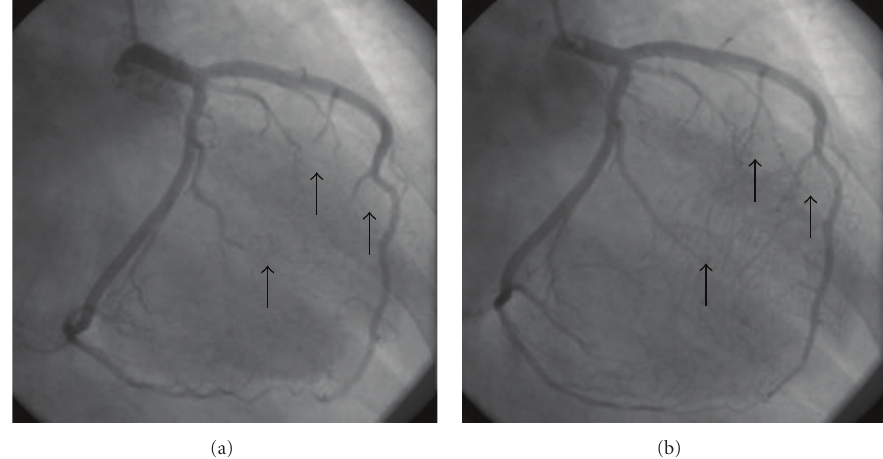
Figure 2: Systolic compression of marginal branches of LCx (a) is seen during systole whereas arteries are fully opened during diastole (b).